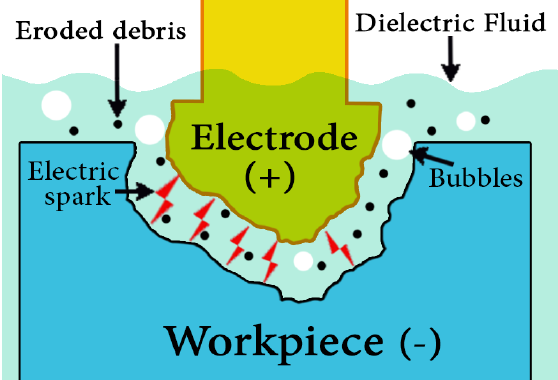
Figure 2. Principle of EDM.